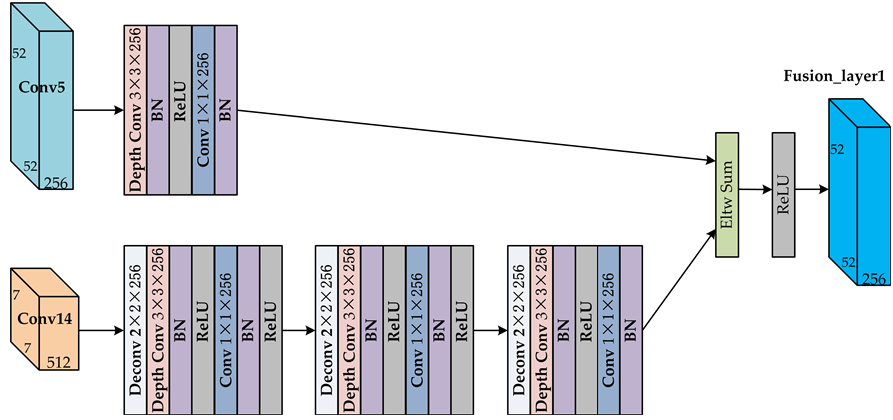
Figure 2. The structure of feature fusion unit (FFU).